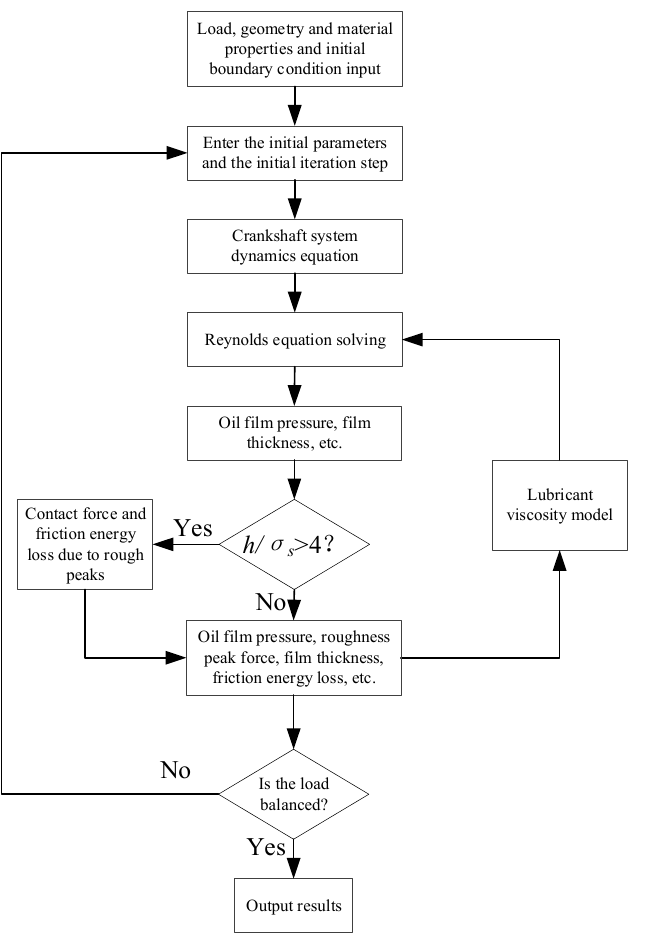
Figure 8. Calculation flow-process diagrams. Table 9. Control parameters of Solver.